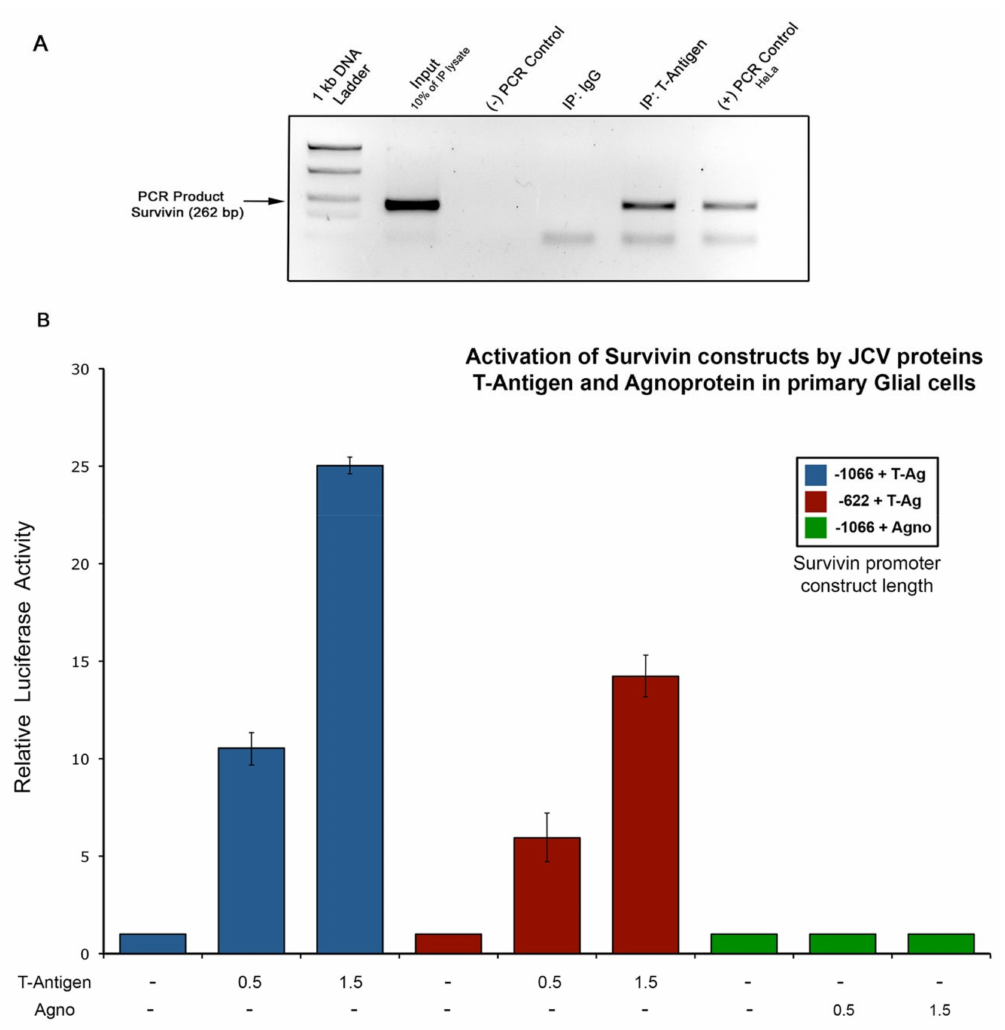
Figure 2. ( A )Human neurotropic polyomavirus JC (JCPyV) T-Antigen transactivates the Survivin promoter. Chromatin Immunoprecipitation (ChIP assay) of primary astrocytic cell cultures